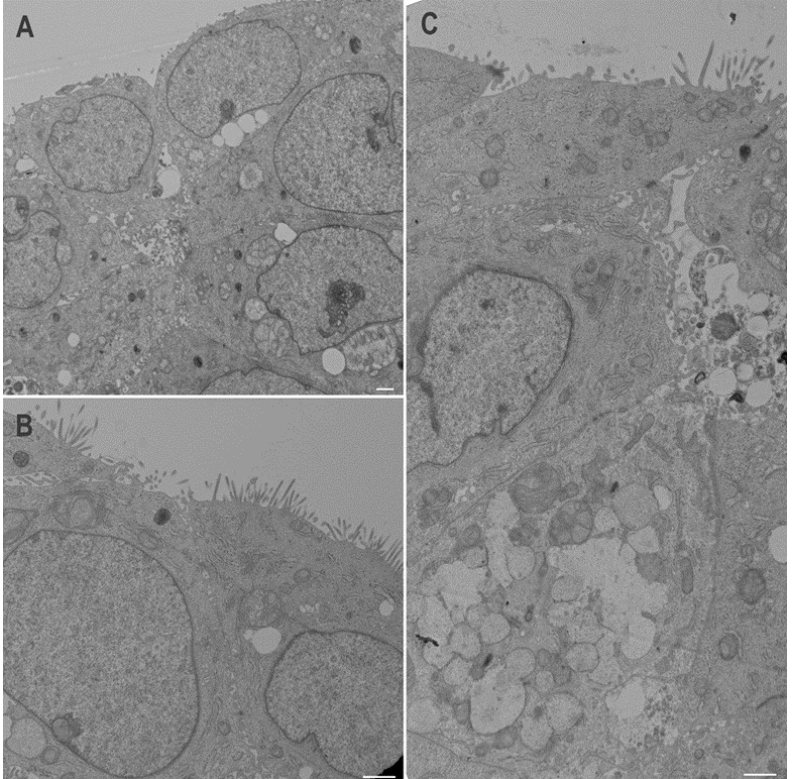
Figure 8. Transmission electron microscopy of HT29 stably expressing shCtrl or shYAP1 at 8PC. ( A ) Control cells expressing shTAZ are small and multilayered and express limited differentiation characteristics. ( B , C ) Cells expressing shYAP1 are larger and exhibit some absorptive-like features such as regular microvilli ( B ) and goblet cell-like features such as mucinous granule forming goblet-like aggregates (lower part of (C)). Scale bars = 1 μ m.